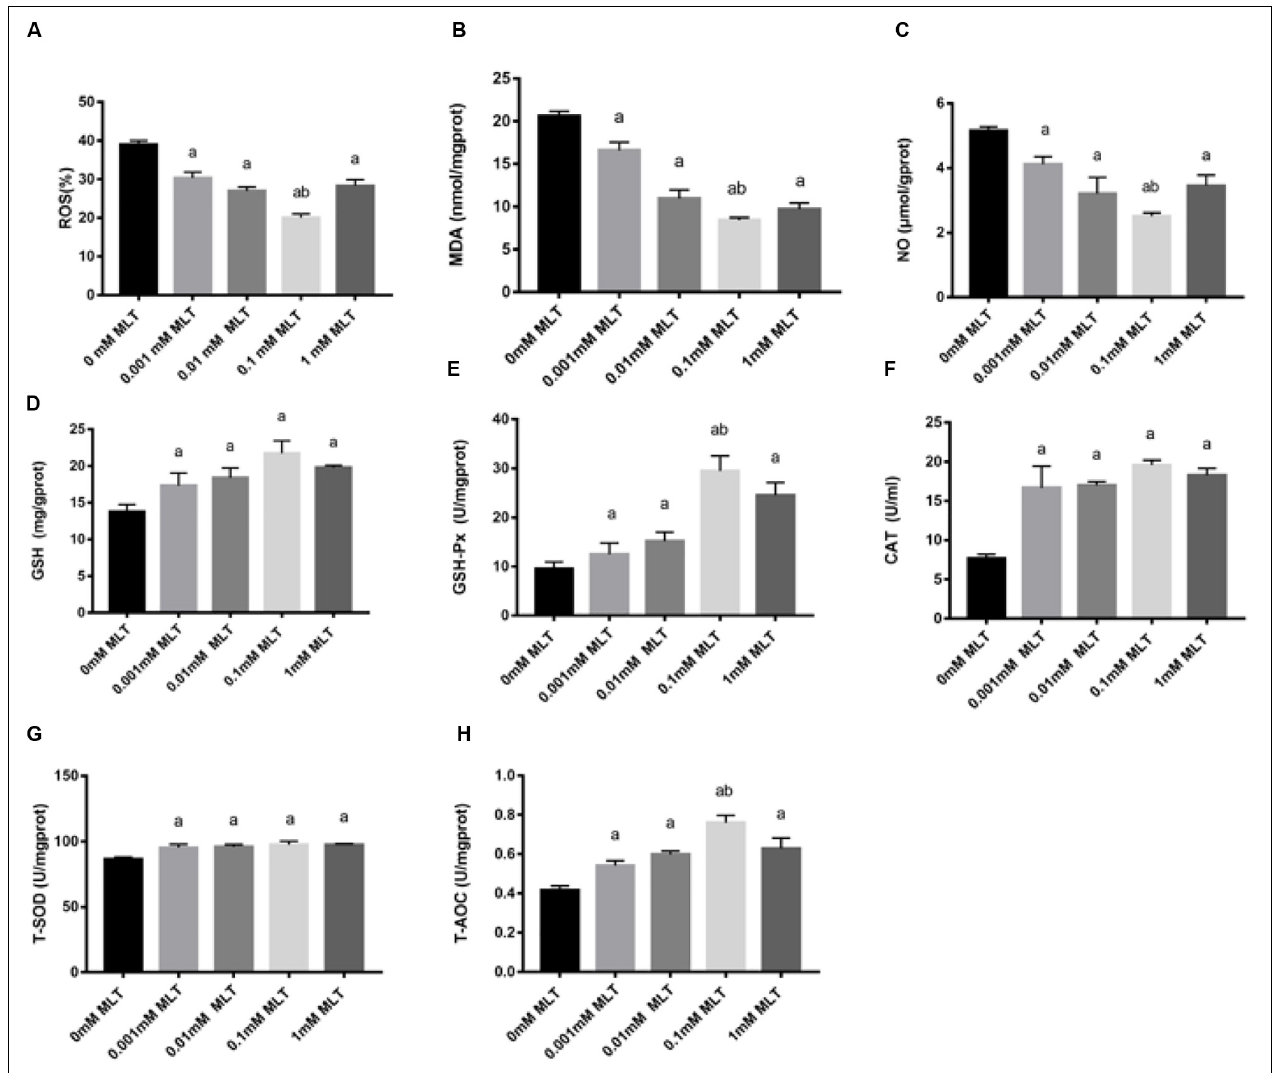
FIGURE 4 | MLT alleviated oxidative stress in cryopreserved OTs. ROS (A) , MDA (B) , NO (C) , GSH (D) , GSH-Px (E) , CAT (F) , T-SOD (G) , and T-AOC (H) . Data are shown as the mean ± SEM. a P < 0.05 compared with the 0-mM MLT-untreated group; b P < 0.05 compared with the MLT-treated